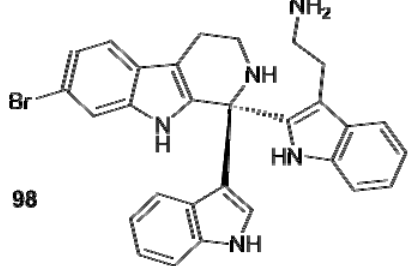
Figure 12. Dihydro-  -carbolines ( 99 , 100 ) and  -carbolines ( 101–103